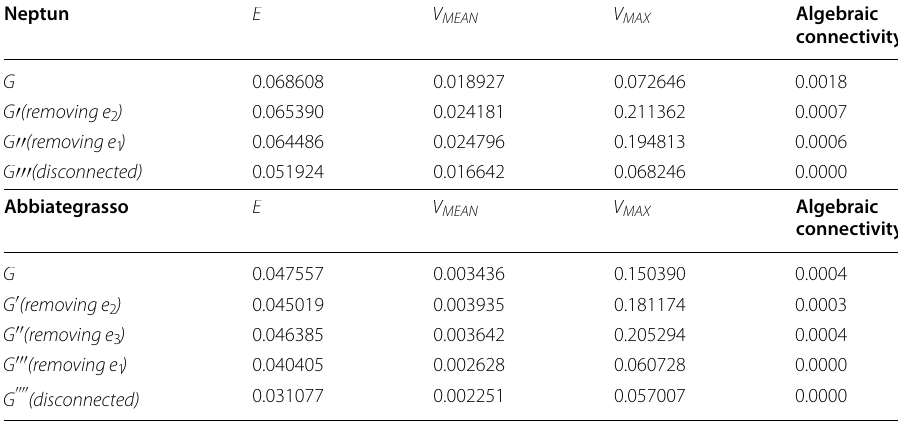
Table 2 Vulnerability measures Neptun